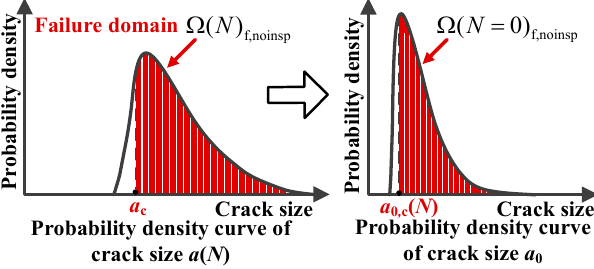
Figure 3. Schematic diagram of probability space transformation under single variable.